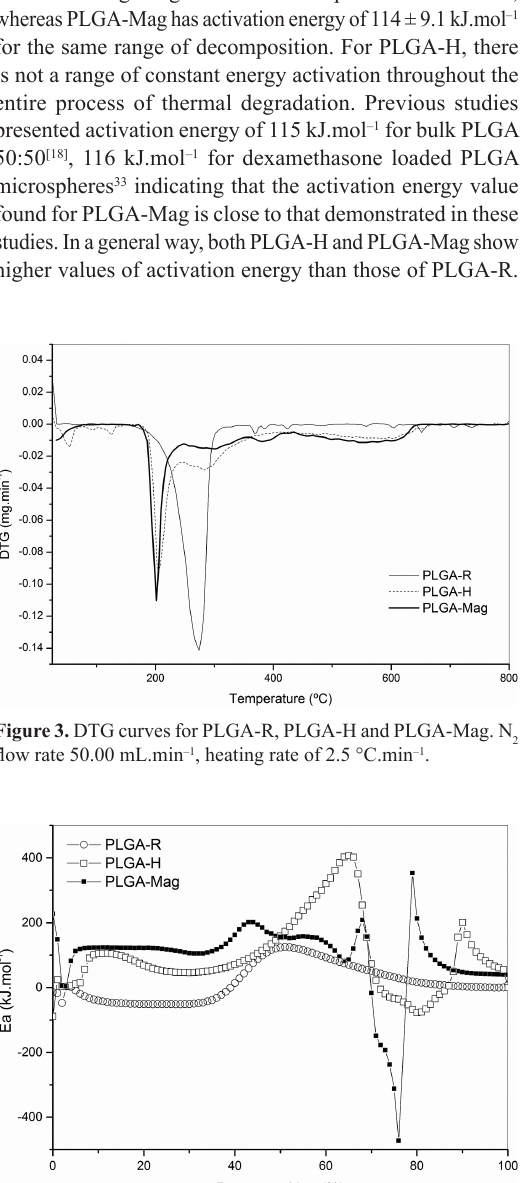
Figure 4. Variation of activation energy versus decomposition rate obtained by Vyazovkin method.